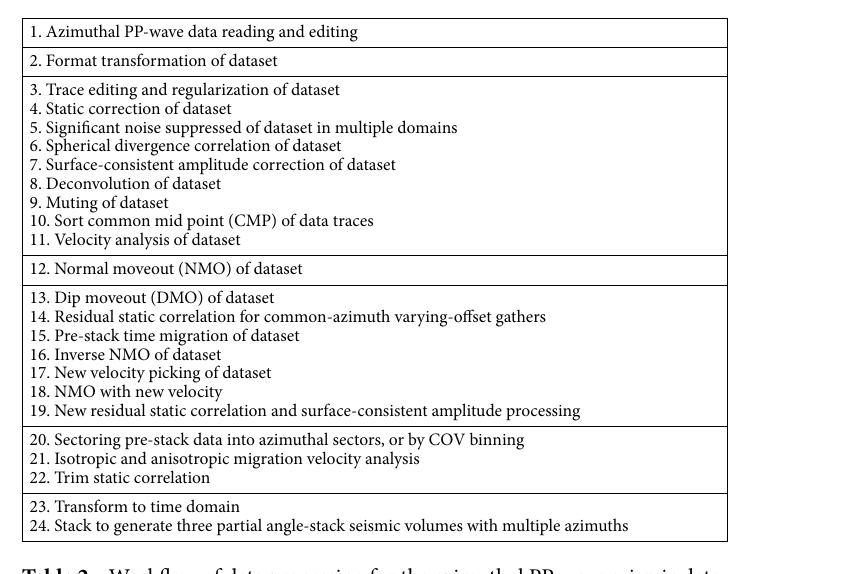
Table 2. Workflow of data processing for the azimuthal PP-wave seismic